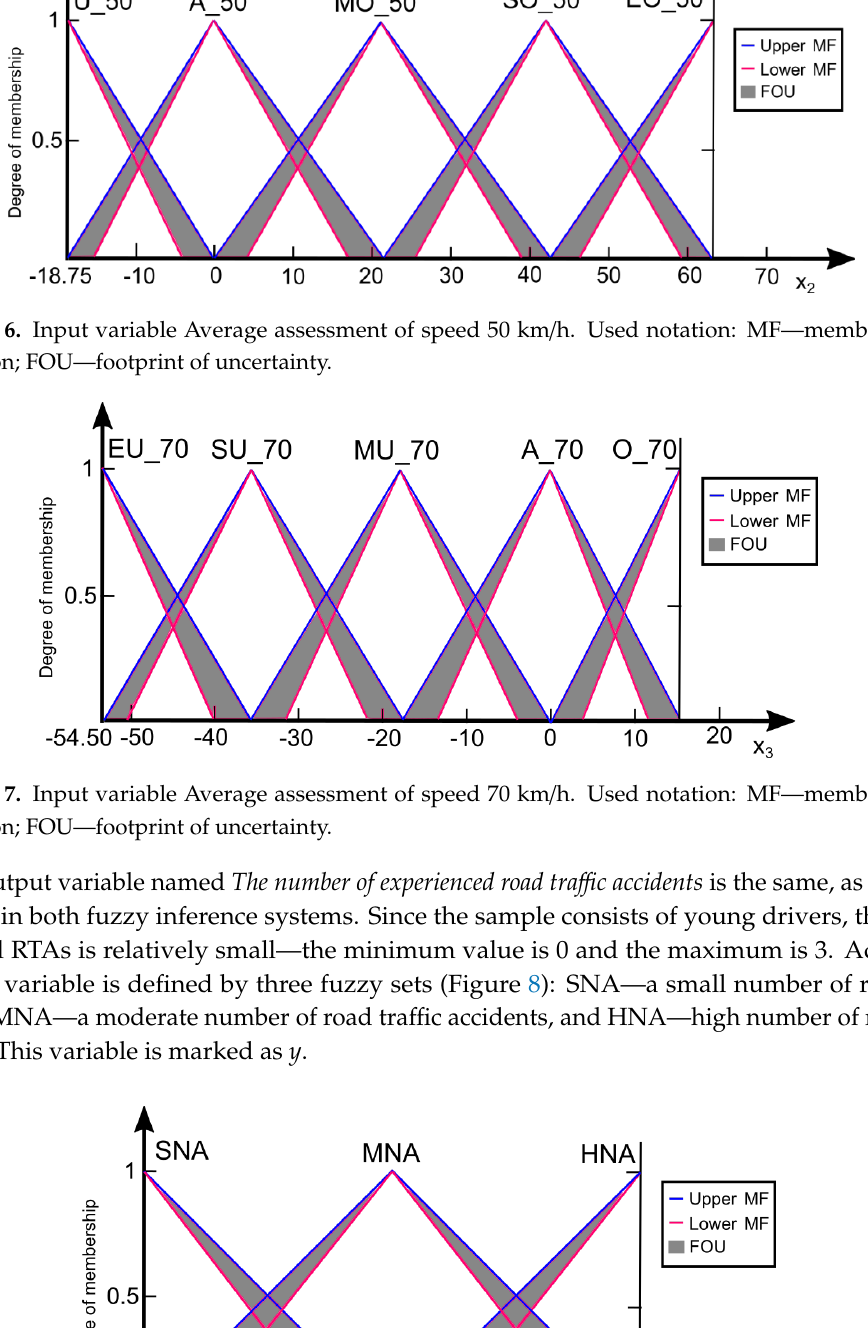
Table 2. Description of a sample considering errors in space assessments.